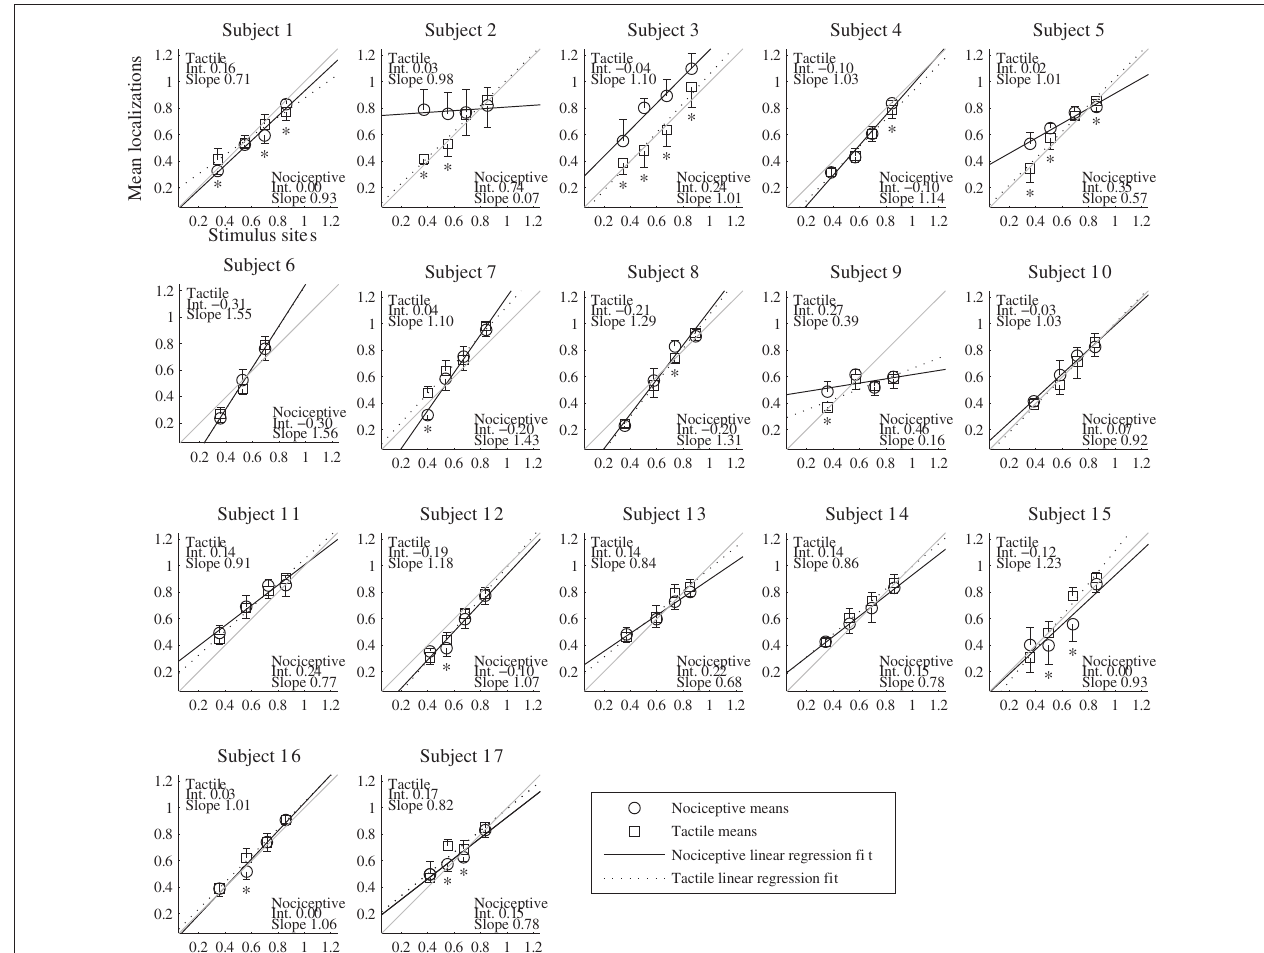
FIGURE 4 | Results of the localization experiments as a function of the stimulus site for each subject. The localizations (vertical axis) are plotted as function of the sites (horizontal axis); both localizations and sites are shown as fraction of each subject’s arm length, with 0 being the elbow and 1 the wrist. Each marker represents the mean localization of one site for either the nociceptive (circle) or the tactile (square) stimulus condition. The bristles indicate the standard deviations; these are plotted to one side only. The lines